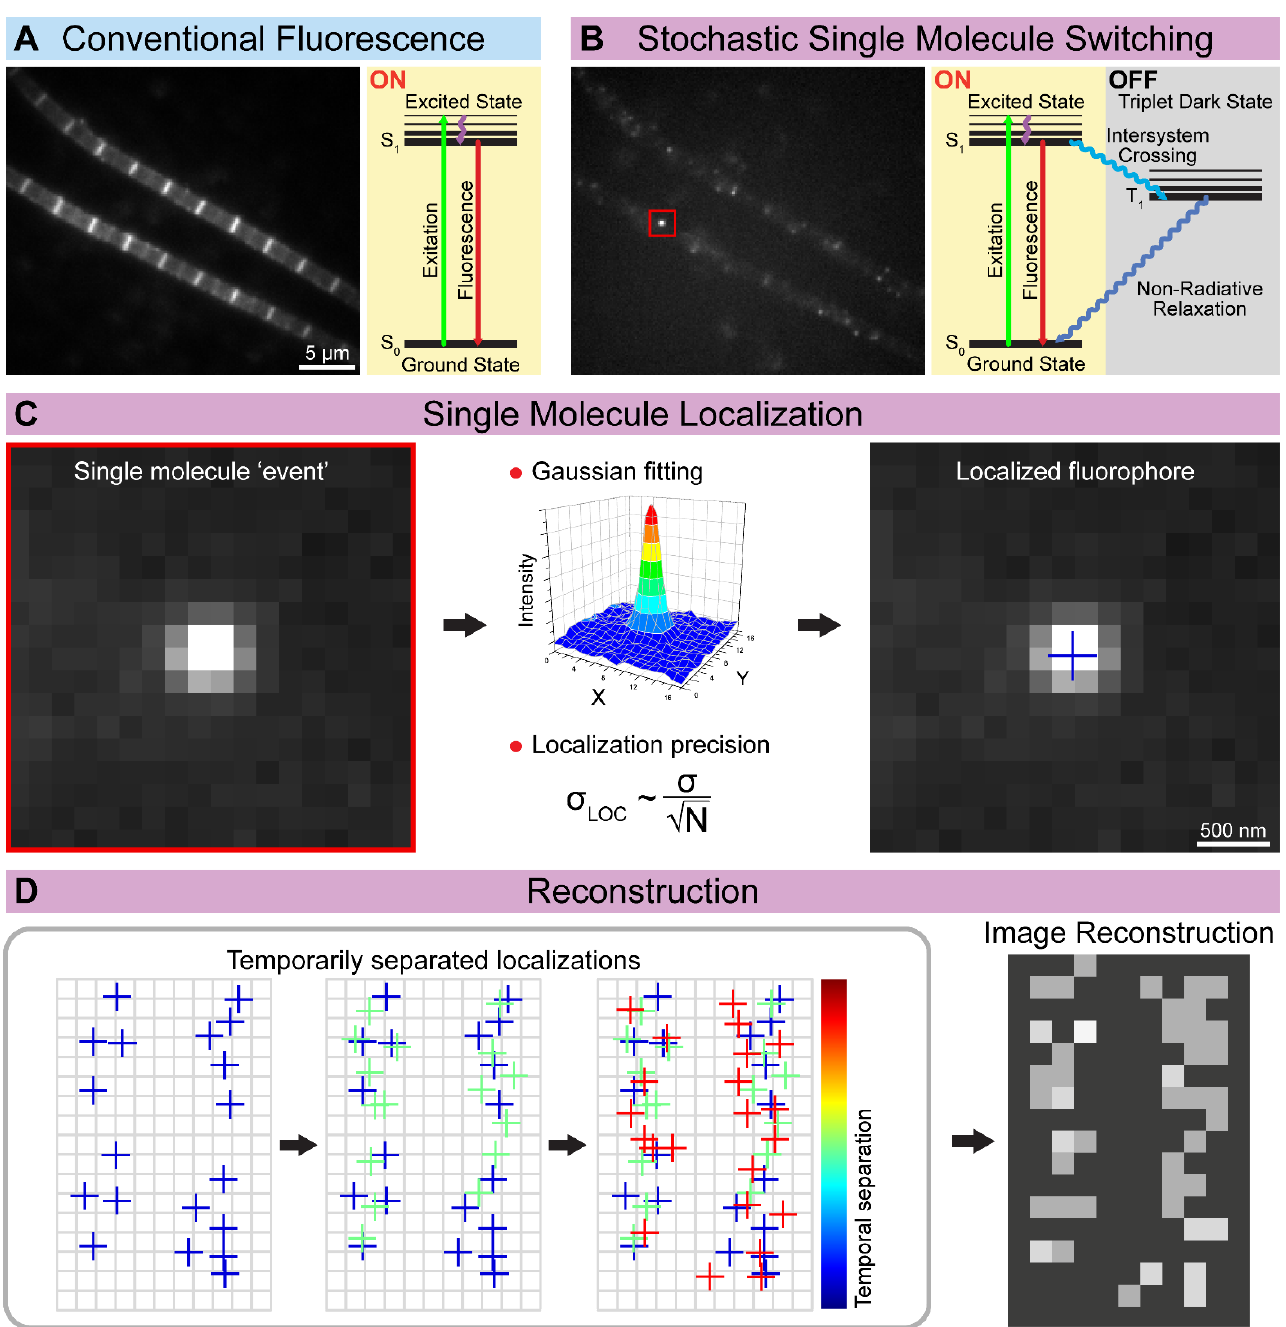
Figure 3. The concept of single-molecule localization microscopy (SMLM). ( A ) The conventional widefield approaches excite all the fluorescent molecules simultaneously, while ( B ) the SMLM approaches stochastically switch on only a small batch of fluorophores at a given time. ( C ) The position of the sparsely localized individual fluorescent molecules is determined based on their diffraction-limited image. The centroid position is estimated by 2D Gaussian fitting, and theoretically, the precision (σ LOC ) is only limited by the number of photons (N) detected. ( D ) The spatially separated single-molecule events are recorded over time, and their determined position is used to reconstruct the final high-resolution image.